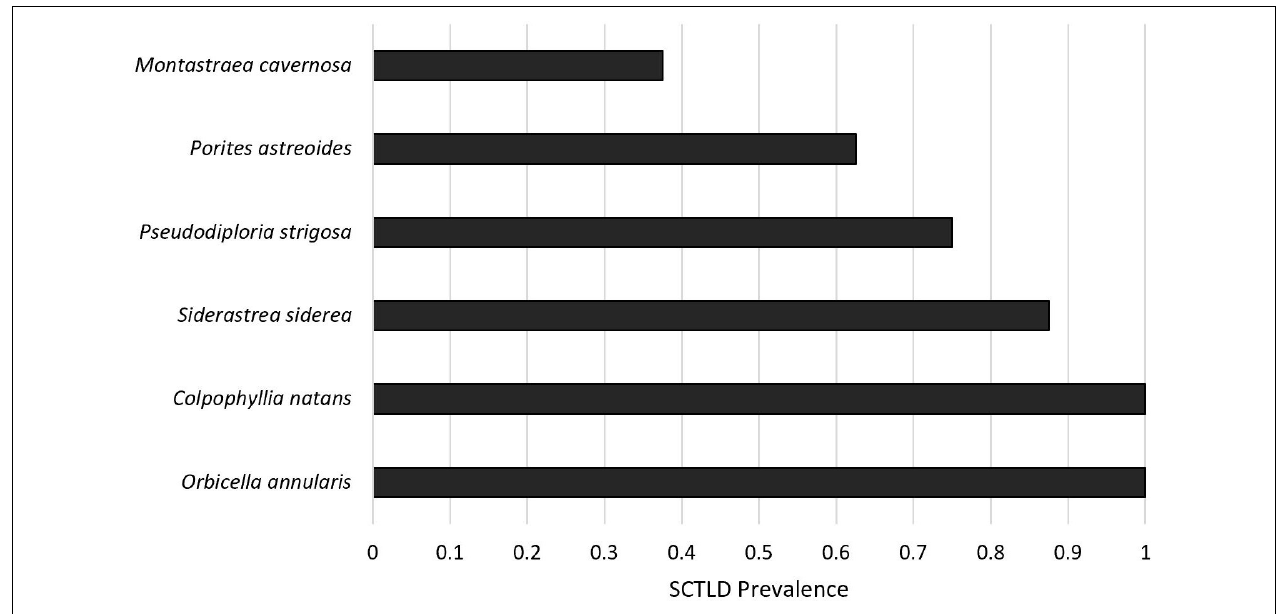
FIGURE 3 | Disease prevalence. Proportion of healthy fragments ( n = 8 per species) exposed to a diseased Diploria labyrinthiformis that developed lesions corresponding to stony coral tissue loss disease (SCTLD) after 8 days.